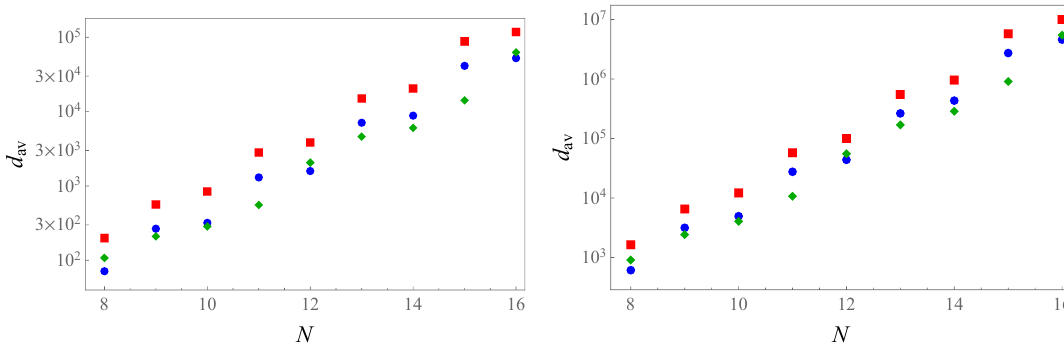
Figure 4 . Logarithmic plot of the average degeneracy d av of the spectra of the model (2.1) (blue dots), the HS chain (2.3) (red squares) and the D N HS chain (2.8) (green rhombuses) as a function of the number of spins N for 8 6 N 6 16 and m = 3 (left) or m = 4